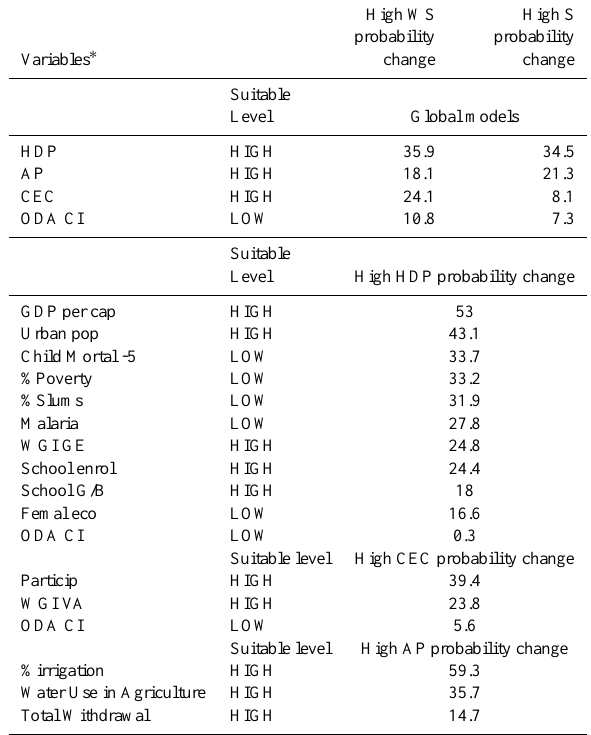
Table 10. Recapitulative table on probability variations (difference between recomputed and initial